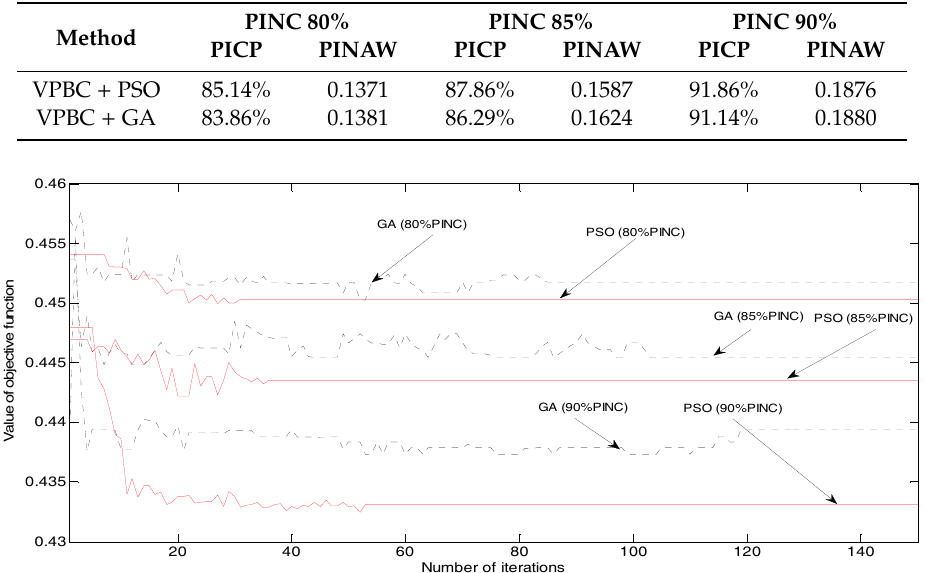
Figure 13. Changes in the objective function for the PSO and GA optimization.